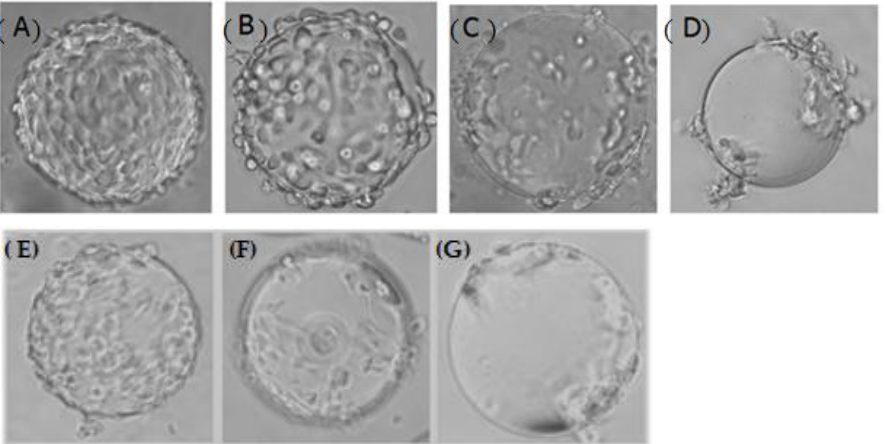
Figure 9. Cytopathic effect after infection with ISKNV ( A – D ) or SCRV ( E – G ) observed under the microscope (40×). ( A ) No obvious variation appeared at the first 2 days post infection (d p.i) with ISKNV; ( B ) Infected cells were enlarged and clustered at 3 – 4 d p.i.; ( C ) CPE appeared in more than 90% of the cells at 5 d p.i.; ( D ) Most of the cells detached from the microcarriers; ( E ) Cell shrinkage and rounding were observed at 12 h p.i.; ( F ) Some cells detached from the microcarriers at 24 h p.i., drawbench and plaque appeared; ( G ) Most of the cells detached from the microcarriers.